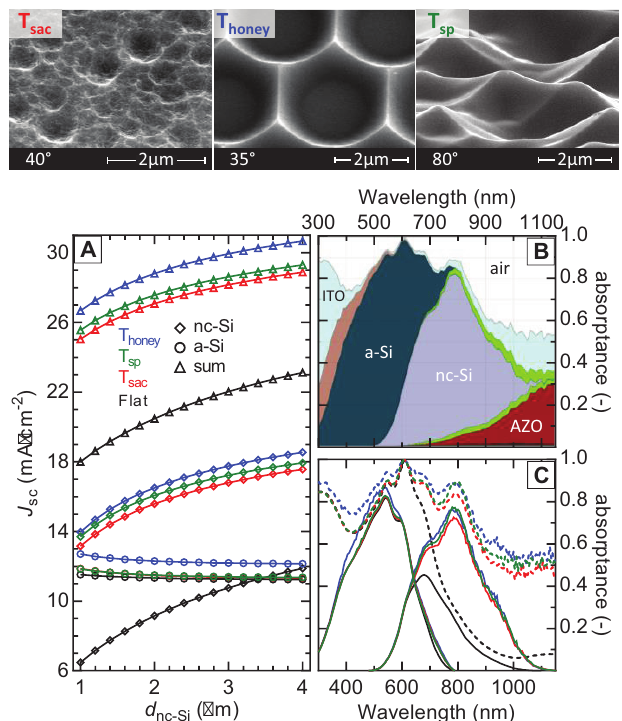
Fig. 9. Simulated performance of a-Si/nc-Si tandem devices on fl at substrates and substrates with T sac (red), T sp (green) and T honey (blue) textures. SEM images (top) show surface morphol- ogy T sac , T sp and T honey . A) shows the J sc of the a-Si junction, nc- Si junction and the sum of both junctions for the different substrate types, as a function of nc-Si absorber thickness ( d nc (cid:3) Si ). B) shows the spectral absorptance in each of the layers of the tandem device on T honey . In addition to the layers indicated in the plot (air, ITO, a-Si, nc-Si, AZO) absorptance in the p-nc-SiO X :H layer (brown), n-nc-SiO X :H layers (green) and Ag layer (dark grey, close to bottom horizontal axis) are indicated. C) shows the a-Si and nc-Si absorptance curves and 1- R curves for the different substrate types, for tandem device with d a (cid:3) Si = 300nm and d nc (cid:3) Si =1.2 m